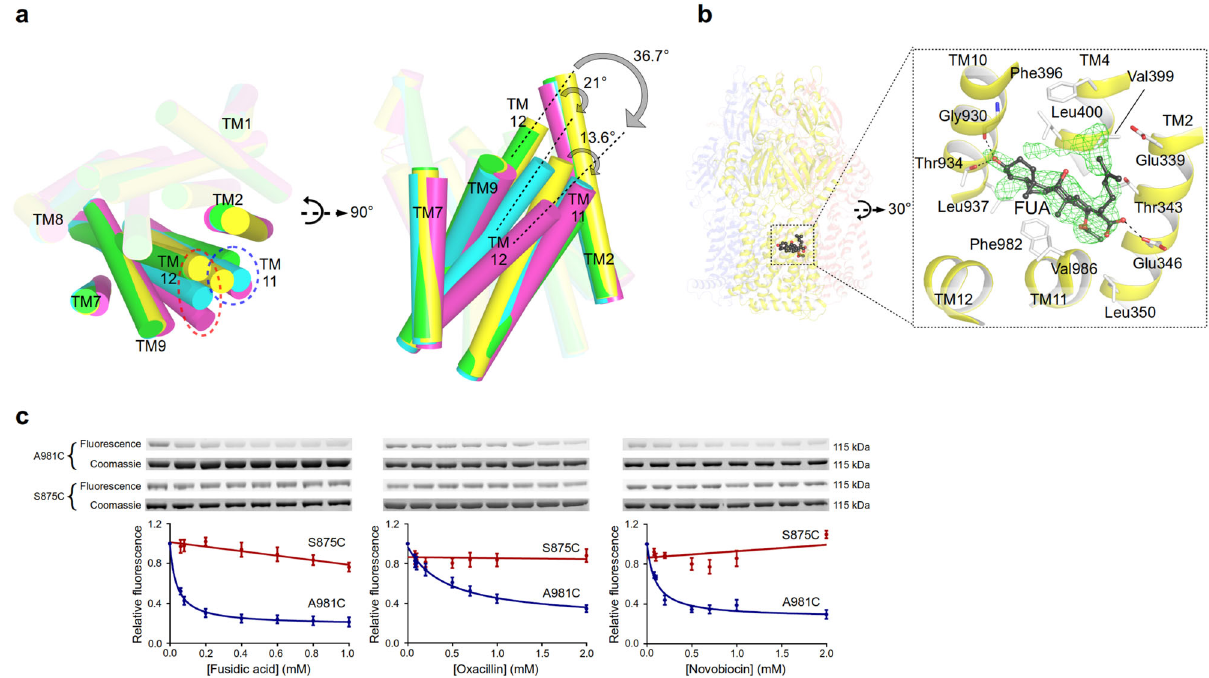
Fig. 6 Deep transmembrane domain-binding pocket (TMD-BP) and a model for allosteric drug binding and transport. a Conformational changes of TM11/TM12 in the transmembrane domain of the T protomer induced by drug binding (yellow, unliganded T; cyan, partially induced T in presence of β - lactams; green, partially induced T of 3-FOR bound Gly619Pro; magenta, fully induced T in presence of fusidic acid (FUA) bound to the TMD-BP. b FUA (carbon, black; oxygen, red) binding to TMD-BP of the T protomer (yellow). Inset: Polder electron density map assigned to FUA is contoured at 4.5 σ . c Substrate protection experiment of AcrB-cl_Cys981 and AcrB-cl_Cys875 (negative control) by in-gel fl uorescence of MTS-rhodamine modi fi ed proteins in dependence of the drug concentration (from left to right increasing concentration of drugs). Data are presented as mean ± s.e.m. of N ≥ 4 independent experiments. The calculated apparent K i app for fusidic acid, oxacillin, or novobiocin is 38, 446, or 95 μ M, respectively (Source Data Fig.